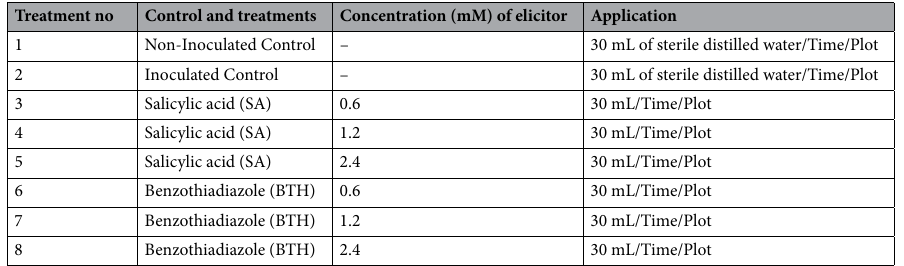
Table 2. Description of elicitor treatments.